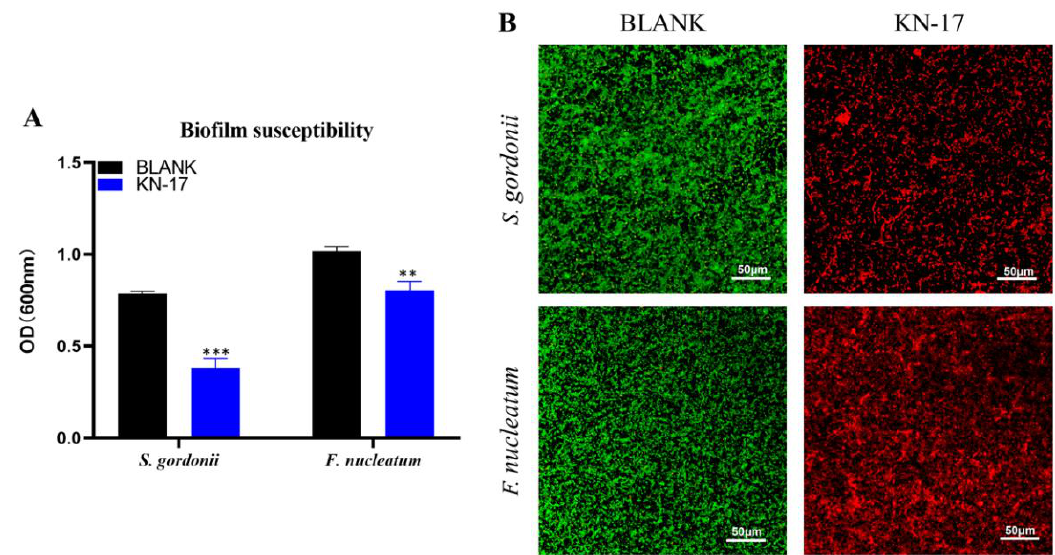
Figure 3. ( A ) Antibiofilm effects of KN-17 against S. gordonii and F. nucleatum , respectively. The data are presented as mean ± SD; n = 3. ** Indicates statistical significance between the BLANK group and KN-17 group. (** p < 0.01, *** p < 0.001, ANOVA). ( B ) The biofilms treated with KN-17 were incubated for 24 h ( S. gordonii )/48 h ( F. nucleatum ). The biofilms were stained and imaged by CLSM. Note: Green (live bacteria), Red (dead bacteria).